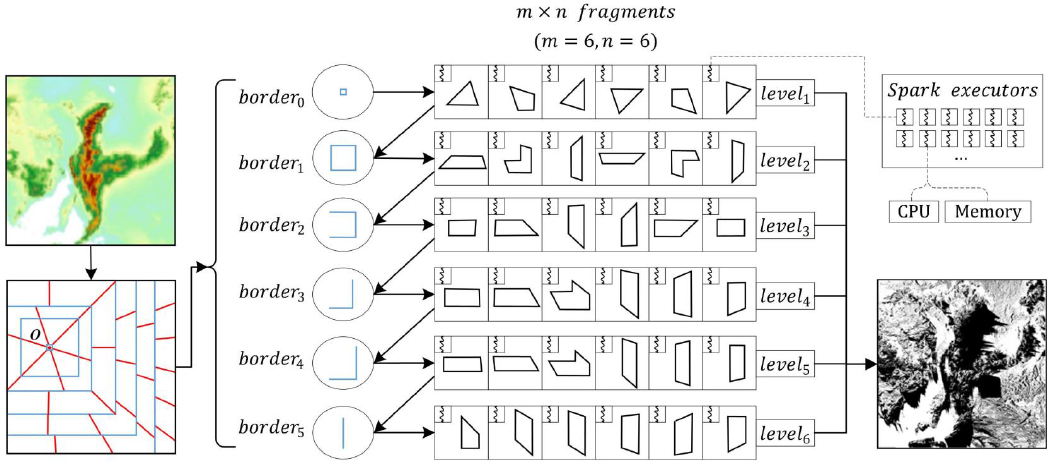
Figure 3. Principle of the ML-XDraw